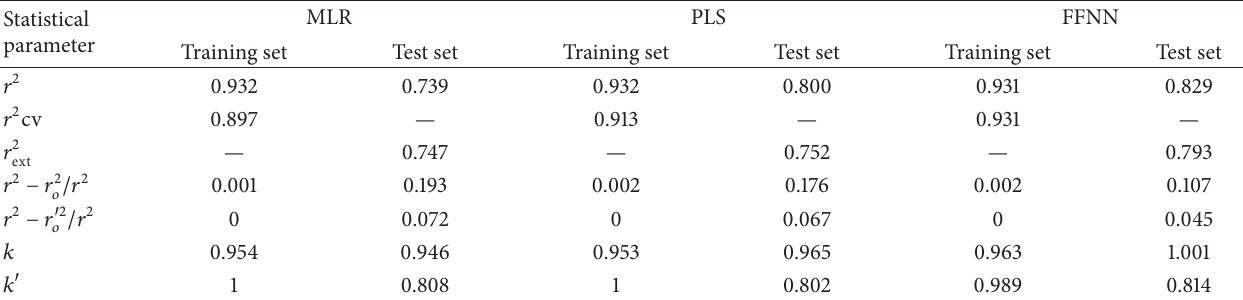
Table 4: Statistical validation parameters obtained in the MLR, PLS, and FFNN